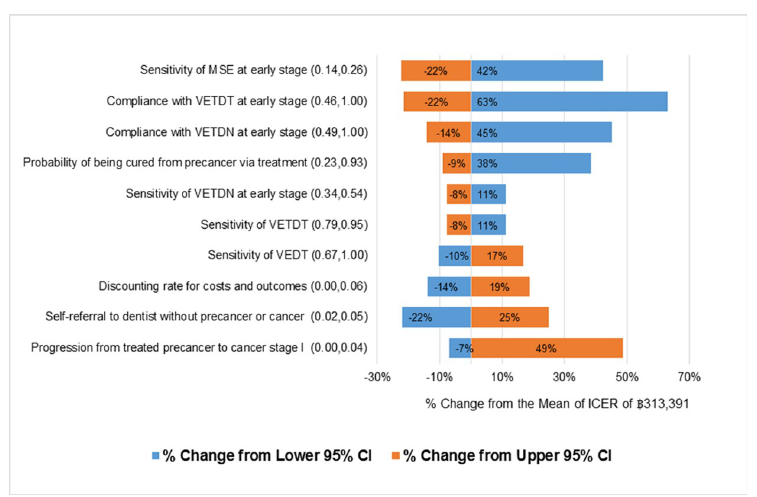
Fig 4. Tornado diagram of ICER sensitivity to plausible ranges of individual